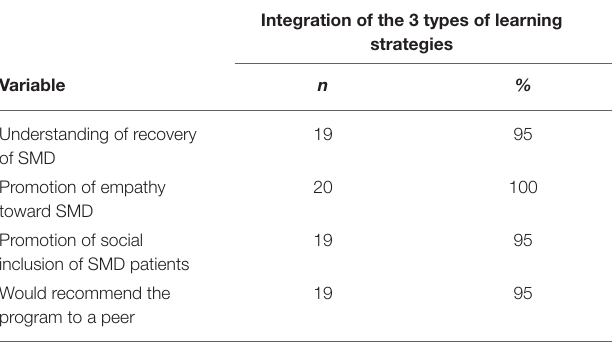
TABLE 3 | Intervention group participants who rate the integration of learning strategies at the top level ( n =